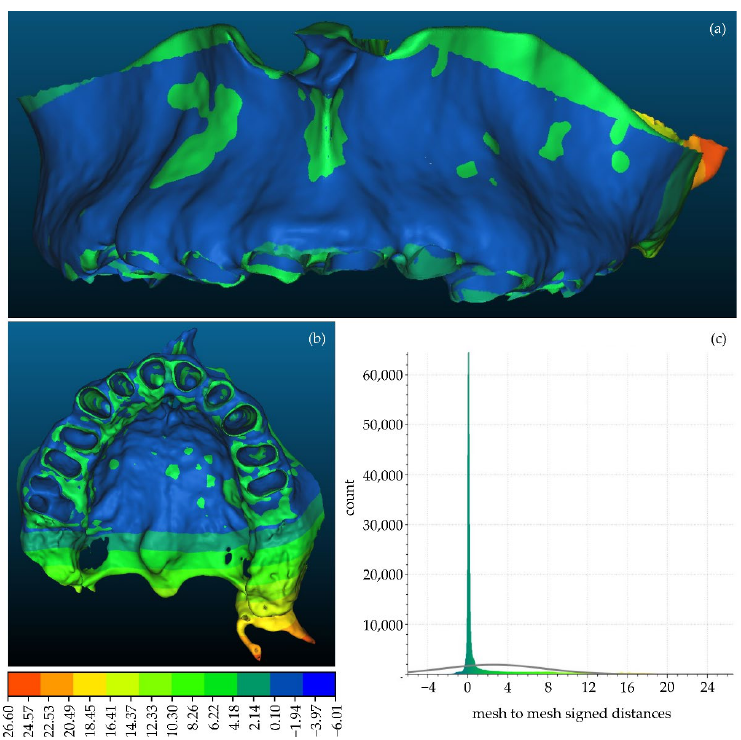
Figure 18. 3D models of alveolar bone after their processing using Geomagic Wrap; ( a ): Experiment 2 (manual segmentation); ( b ): Experiment 4 (semi-automatic segmentation).